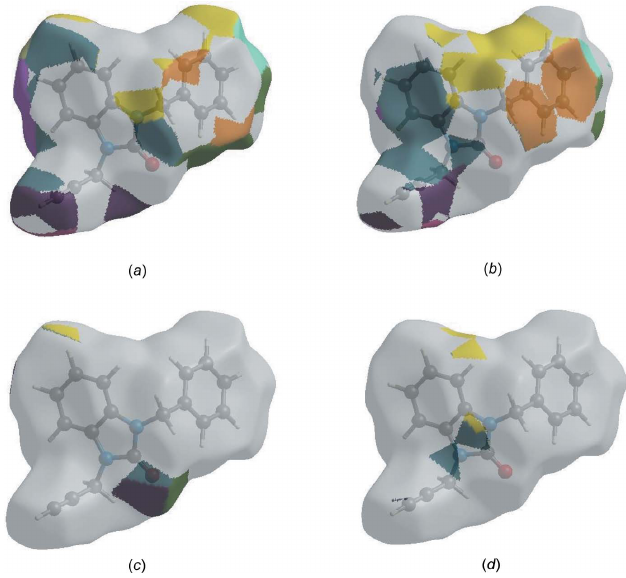
Figure 8 The Hirshfeld surface representations with the function d norm plotted onto the surface for ( a ) H (cid:3)(cid:3)(cid:3) H, ( b ) H (cid:3)(cid:3)(cid:3) C/C (cid:3)(cid:3)(cid:3) H, ( c ) H (cid:3)(cid:3)(cid:3) O/O (cid:3)(cid:3)(cid:3) H and ( d ) H (cid:3)(cid:3)(cid:3) O/O (cid:3)(cid:3)(cid:3) H